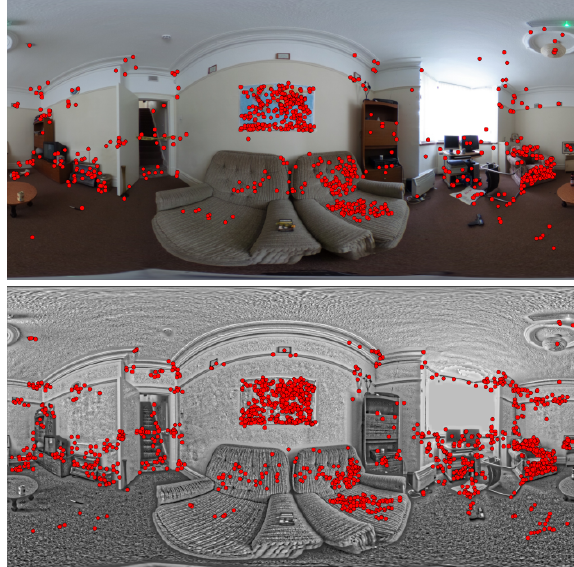
Figure 5. Example of tie point (red dots) distribution without (top) and with (bottom) image pre-processing.